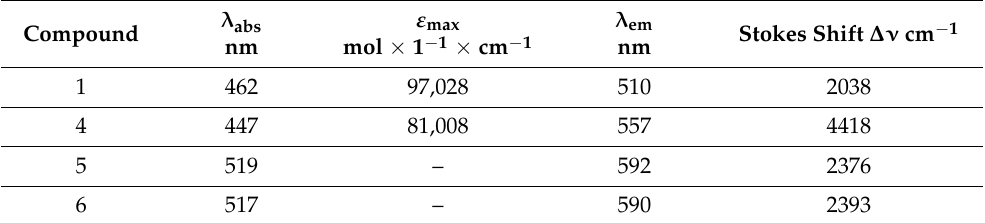
Table 1. Photophysical parameters obtained for 2-((4-(2-ethylhexyl)-1,2,3,3 a ,4,8 b -hexahydrocyclopenta [ b ]indol-7-yl)methylene)malononitrile 1 and similar chromophores 4 – 6 : absorption maximum wave- length λ abs , maximum molar extinction coefficient ε , emission maximum wavelength λ em and Stokes shift ∆ ν